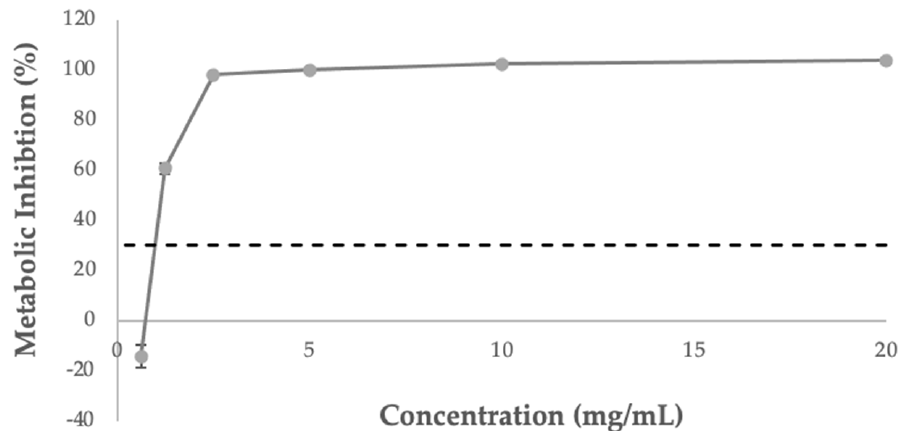
Figure 6. Cytotoxicity profile of sugarcane straw extract dispersed in water when in contact with intestinal Caco-2 cell line, measured by the potential of the extract to inhibit cell metabolic activity. The dotted line represents the 30% cytotoxicity limit, as defined by the ISO 10993-5:2009 standard (ISO 2009). Values are the mean ± standard deviation.